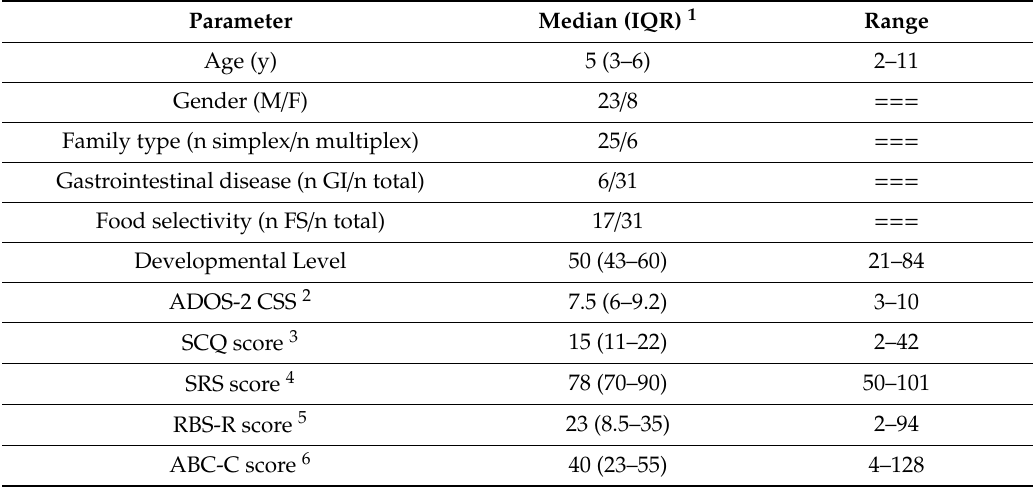
Table 1. Basic demographic and clinical characteristics of 31 children with autism spectrum disorder (ASD). Median and IQR were computed from results obtained in 31 ASD